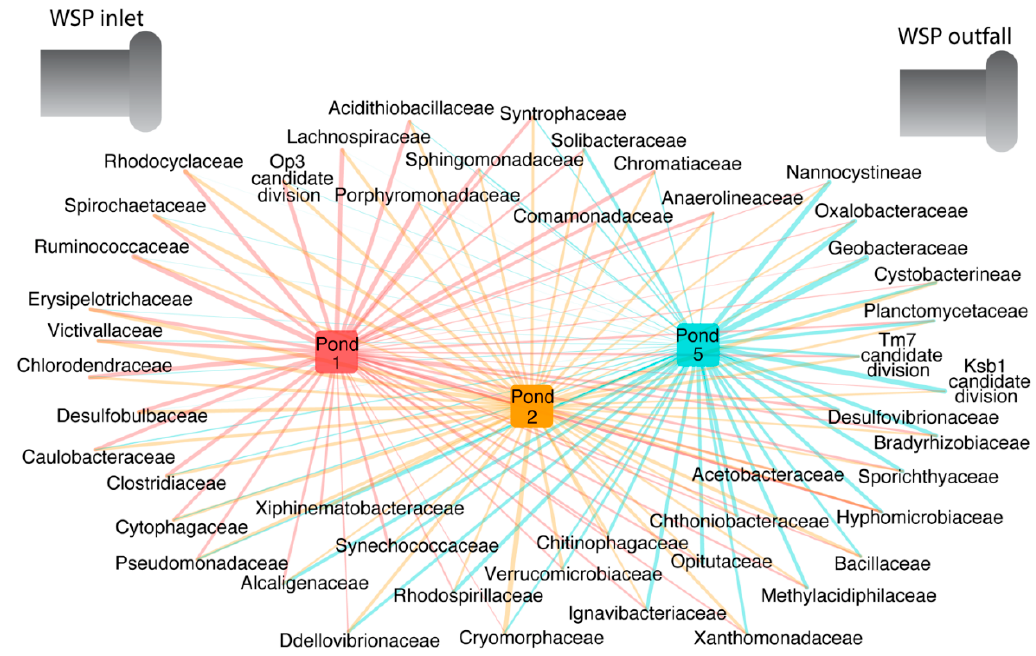
Figure 5. The 48 new pond-indicator families and their relative abundance (as indicated by line thickness) in ponds 1, 2 and 5.